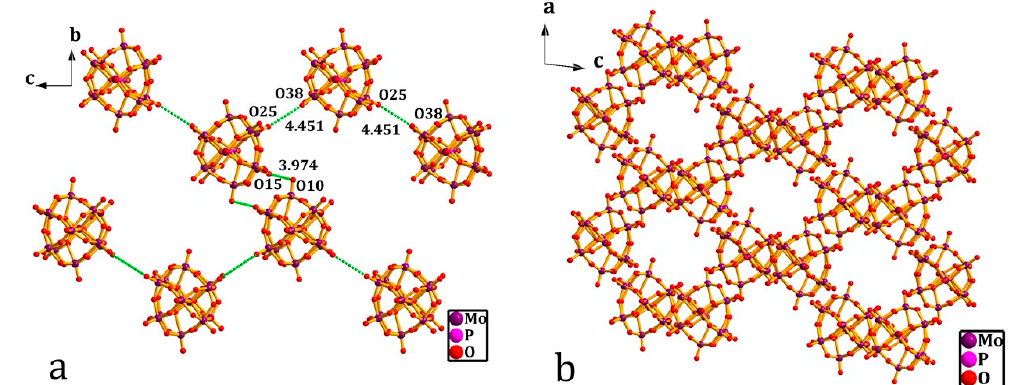
Figure 6. ( a ) The interaction between adjacent [PMo 12 O 40 ] polyoxoanions in the bc plane; ( b ) the packing diagram of [PMo 12 O 40 ] polyoxoanions in the ac plane. The dotted green line represents the O···O interaction.